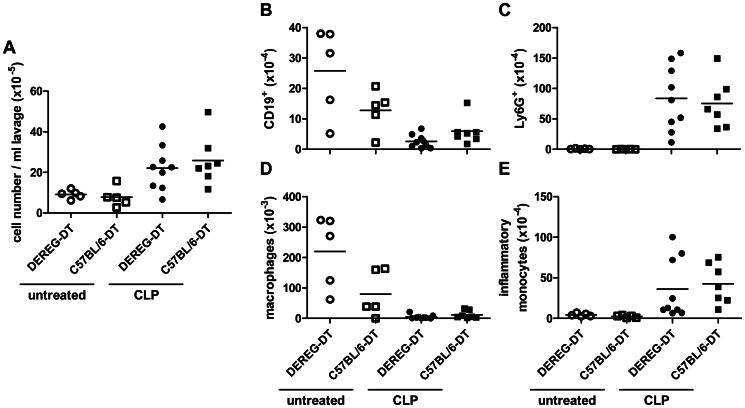
Depletion of Tregs did not alter cell migration into the peritoneum.DEREG and C57BL/6 mice pre-treated with DT (1 µg in 100 µl PBS i.v. on days −2 and −1) were subjected to CLP (n = 7–9 mice/group) or left untreated (n = 5 mice/group). Cells from the peritoneal cavity were harvested by peritoneal lavage 24 h after CLP. The total number of cells was enumerated and related to volume of recovered lavage fluid (A). The numbers of B cells (CD19+) (B), neutrophils (Ly6G+) (C), peritoneal macrophages (F4/80+CD11b+MHCII+) (D) and inflammatory monocytes (F4/80-CD11b+MHCIIlo) (E) was assessed via flow cytometry. Means are shown.